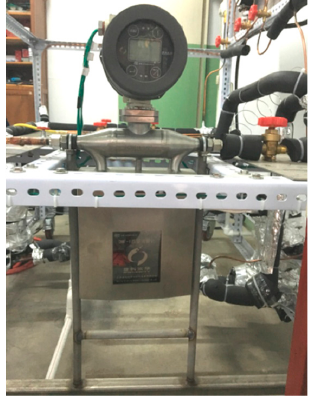
Figure 6. The Coriolis mass flowmeter.